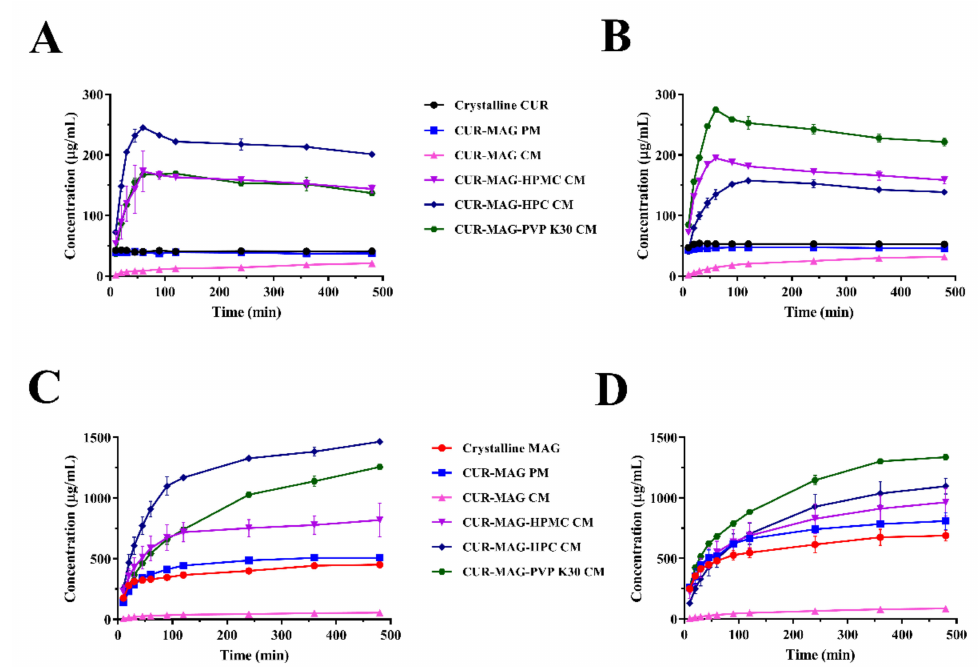
Figure 7. In vitro concentration–time profiles of CUR determined in ( A ) HCl buffer (pH = 1.2) and ( B ) phosphate buffer (pH = 6.8). In vitro concentration–time profiles of MAG determined in ( C ) HCl buffer (pH = 1.2) and ( D ) phosphate buffer (pH =